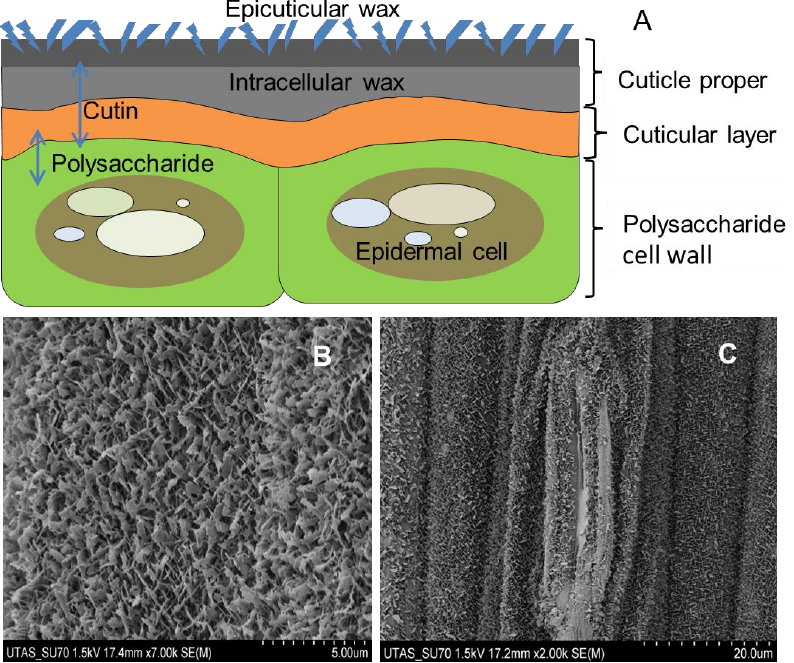
Figure 1. Plant cuticle structure: ( a ) A schematic diagram of plant cuticle, highlighting the major structural features of the cuticle and the underlying epidermal cell layer: cuticle proper, consisting of epicuticular wax, epicuticular wax films, intracuticular wax, and cutin; cuticular layer, consisting of intracuticular waxes, cutin, and polysaccharides; ( b ) scanning electron micrograph image of epicuticular wax film of barley; ( c ) Scanning electron microscopic image of epicuticular wax with stomata of barley leaf surface.